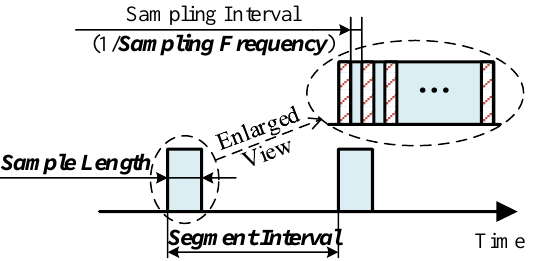
Figure 2. Illustration of three shared control variables.